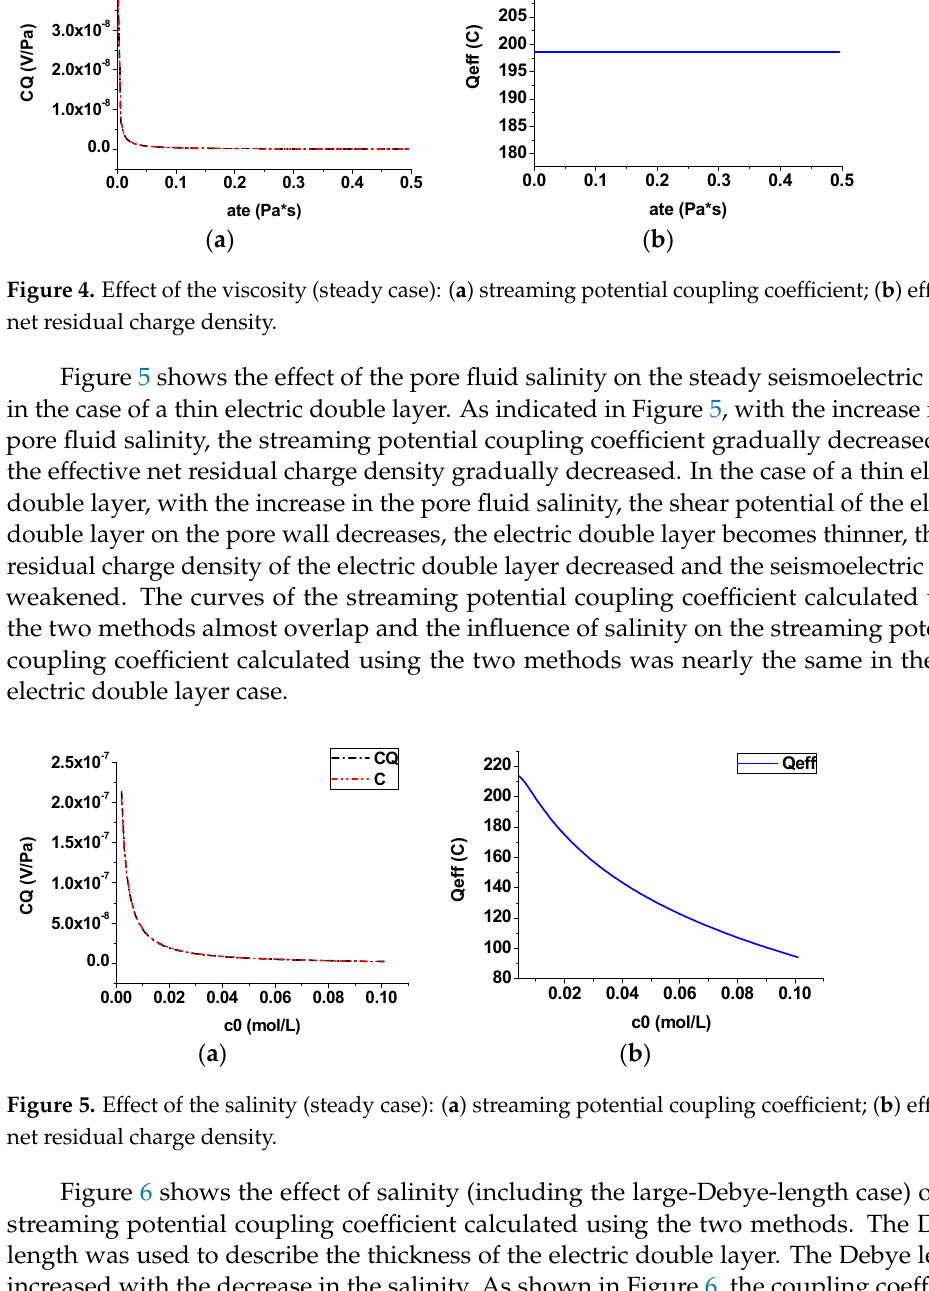
( b ) Figure 6. Effect of the salinity (steady condition, including the large-Debye-length case): ( a ) stream- ing potential coupling coefficient; ( b ) effective net residual charge density. Figure 7 shows the effect of pore size on the seismoelectric effect in the steady case. As shown in Figure 7, with the increase in the pore radius, the streaming potential cou- pling coefficient increased monotonically while the effective net residual charge density decreased monotonically. The larger the pore radius, the smaller the effective net residual charge density in the pore; however, as the corresponding permeability increased (quad- ratic relationship with pore size), the streaming potential coupling coefficient increased. The streaming potential coupling coefficient calculated using the flux averaging method was more affected by the pore size. The Pride theory adopts the assumption of a thin elec- tric double layer and ignores the variation in the seepage velocity with the radial position of the pore [6]; therefore, its results are less affected by the pore radius and the coupling